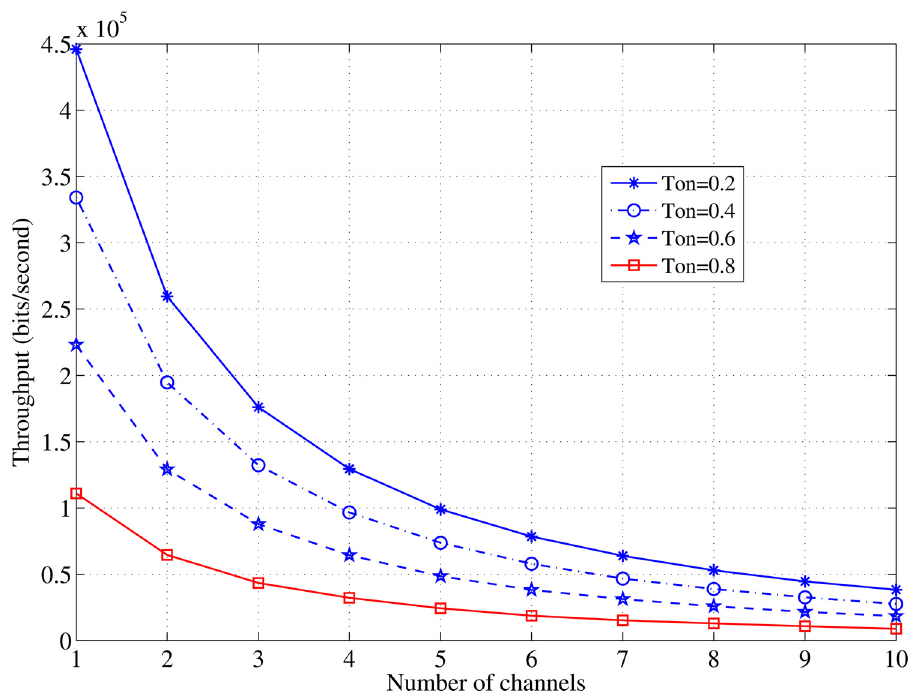
Fig 10. Relationship between C and the throughput in case of various values of τ off ; N = 10, L = 1000 [bits].